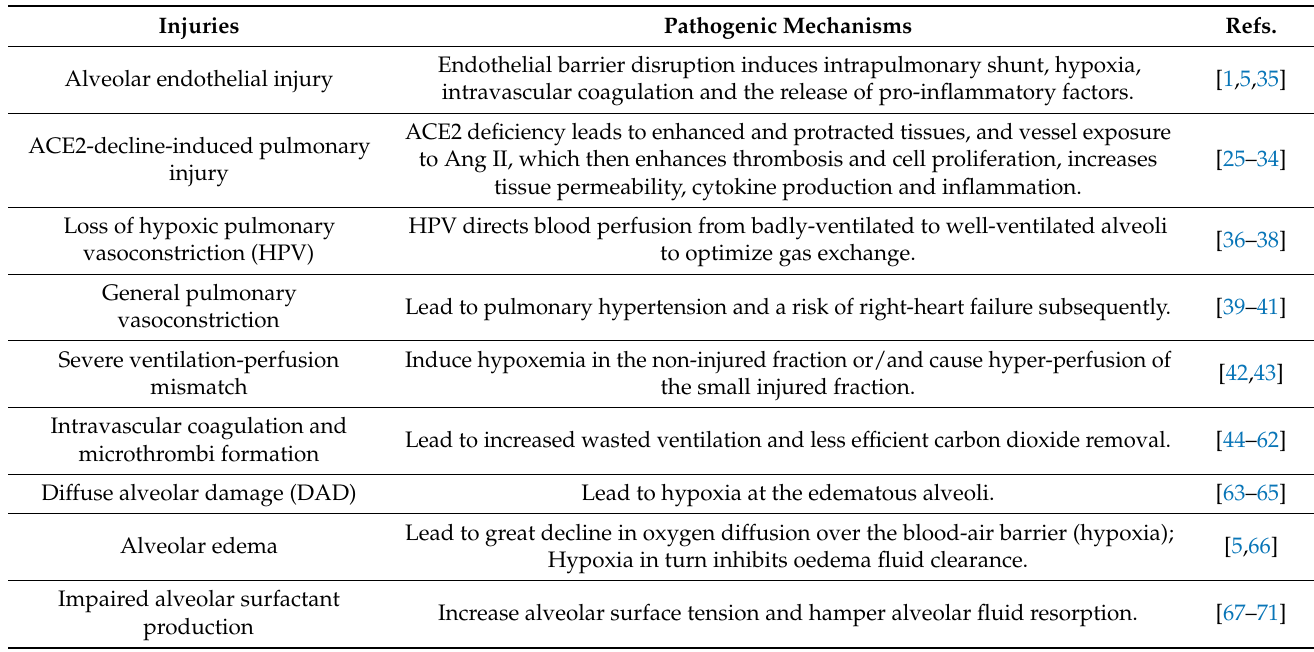
Table 1. Pulmonary pathological changes in